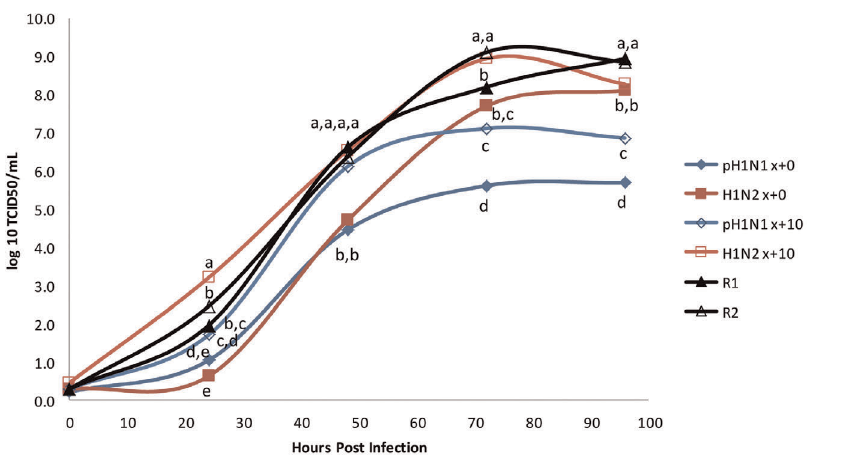
Figure 2. Multicycle growth curves for pH1N1 and H1N2, both before (x + 0) and after 10 passes (x + 10) in ST cells, as well as reassortant viruses R1 and R2. Data represent means of triplicate growth curves. Samples with different subscripts at a time point are statistically